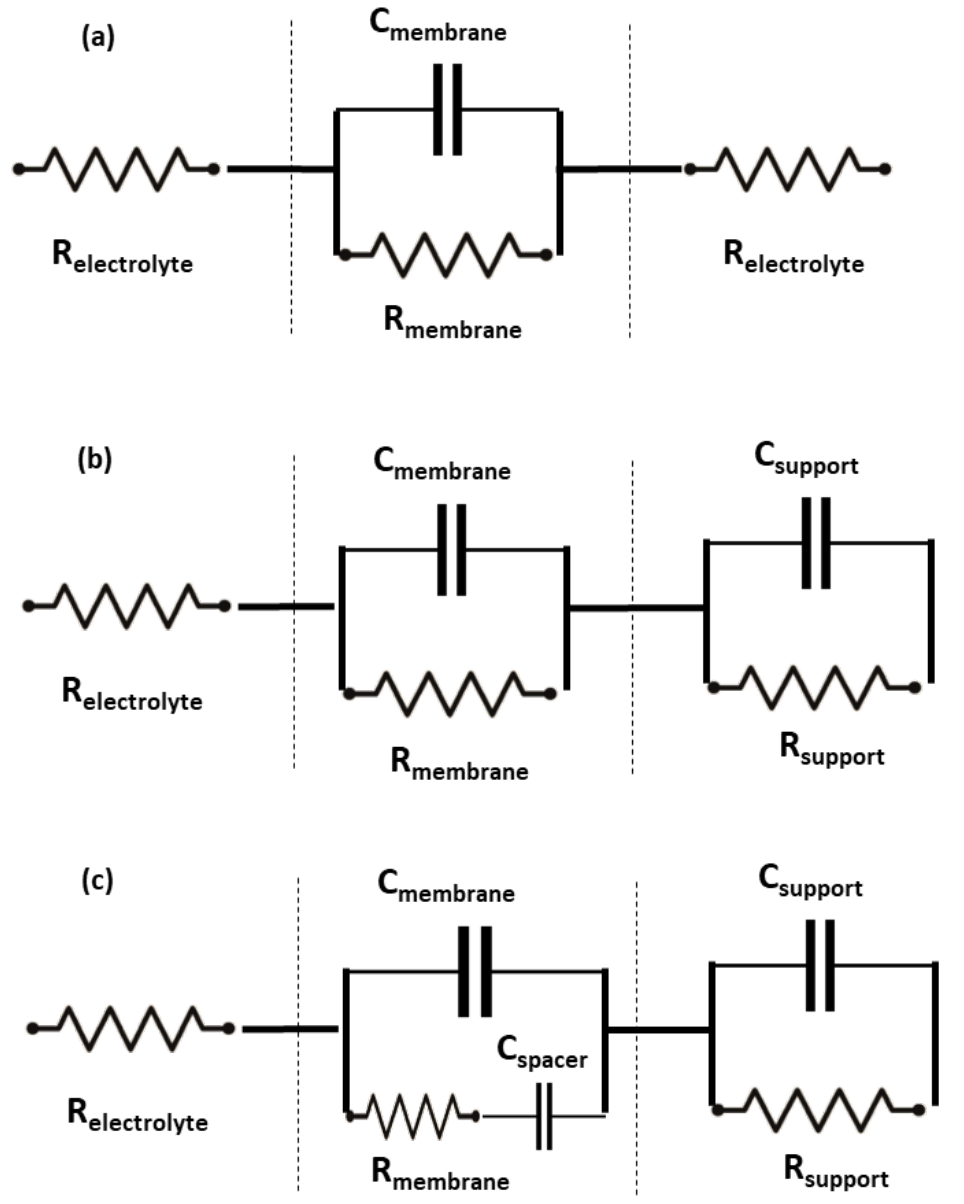
Figure 4. Equivalent circuit models for ( a ) suspended bilayer (i.e., with no direct contact with any electrode); ( b ) supported unanchored bilayer (i.e., floating on the surface of an electrode); and ( c ) anchored bilayer (i.e., through a spacer). The serial resistance R electrolyte corresponds to the ohmic behavior of the electrolyte solution, whereas the capacitance C membrane in parallel with R membrane represents the bilayer system. In the case of anchored membranes, the spacer region contributes its own constant-phase element; Cspacer indicates the electrochemical behavior of spacer and the water layer that separates the membrane from the surface of the